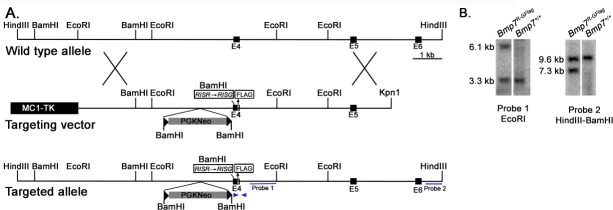
Generation of Bmp7R-GFlag mice.(A) Genomic organization of the wild type Bmp7 allele, the targeting vector and the Bmp7R-GFlagNeo allele. The positions of the external (probe 2) and internal (probe 1) probes used for Southern analysis, and primers (arrows) surrounding the Flag tag that were used for PCR based genotyping are indicated. (B) Southern blot analysis of genomic DNA from targeted or non-targeted (Bmp7+/+) ES cells. Genomic DNA was digested with EcoRI or HindII and BamHI and hybridized with Probe one or Probe 2.